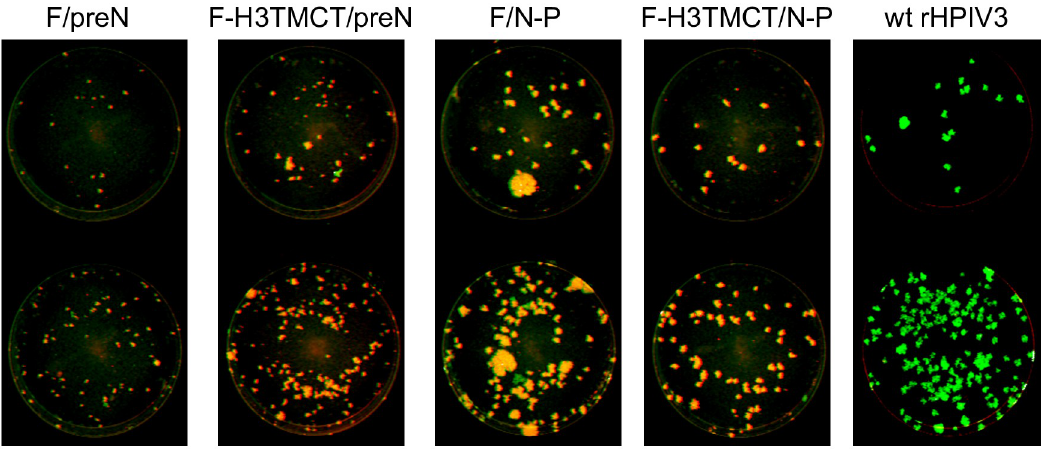
Fig 2. Stability of expression of RSV F protein by rHPIV3-RSV-F vectors evaluated by a double-staining immunofluorescence plaque assay. Vero cells were inoculated with 10-fold serial dilutions of the P4 stock of F-H3TMCT/N-P obtained from terminal dilution from transfection #1 and P2 stocks of F/preN, F-H3TMCT/preN, and F/N-P from transfection #2 (see Results). Cells were infected in duplicate and incubated for 6 days at 32˚C under a 0.8% methylcellulose overlay. The cells were fixed and subjected to double-staining immunofluorescence with a rabbit polyclonal hyperimmune serum raised against HPIV3 virions and a mixture of three conformationally-dependent murine anti-RSV F MAbs [22]. Secondary antibodies were infrared dye-labeled donkey anti- rabbit 800-CW and donkey anti-mouse 680-LT. The Odyssey infrared imaging system was used to acquire plaque images. The infrared dyes were pseudo-colored to appear green and red for rHPIV3 and RSV F antigens, respectively. The plaques co-expressing rHPIV3 and RSV F antigens appear yellow. Plaques in which expression of RSV F could not be detected by the three conformationally-dependent MAbs appear green. Representative monolayers are shown.